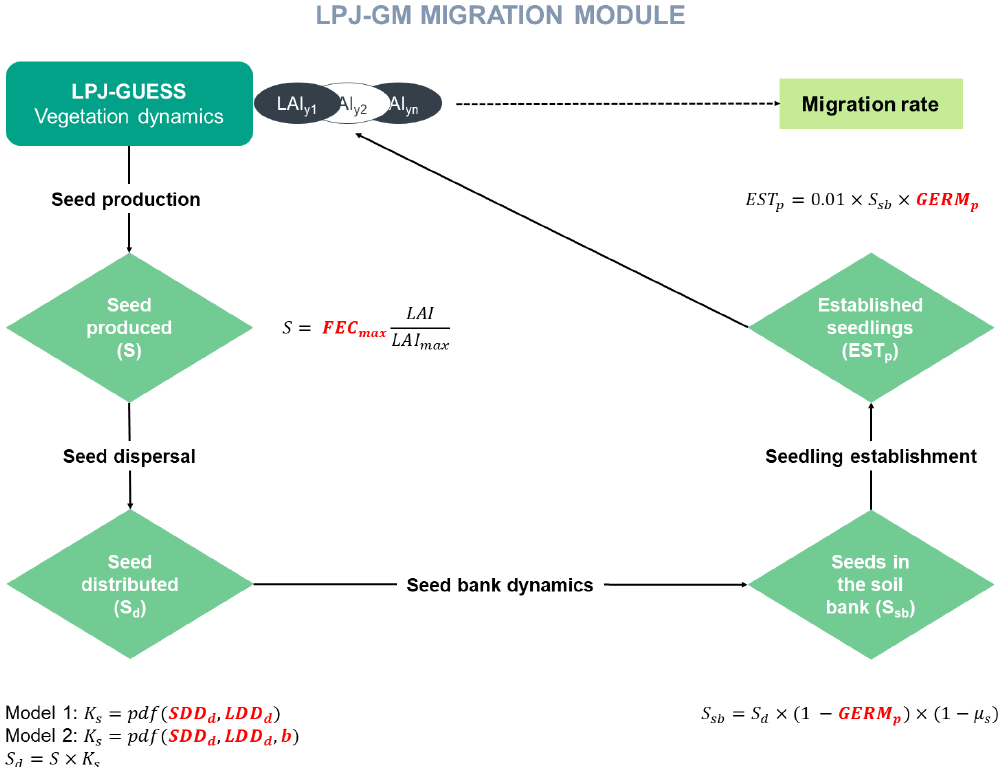
Figure A1. Migration module of the model LPJ-GM 1.0. Migration consists of four processes: (1) seed production, (2) seed dispersal via a probability density function (PDF, dispersal kernel), (3) seed bank dynamics, and (4) seedling establishment. Migration parameters are highlighted in red. Model 1 and Model 2 refer to the default and modified model structures employing negative exponentials or species- specific fat-tailed kernels, respectively, for seed dispersal (see Sect.